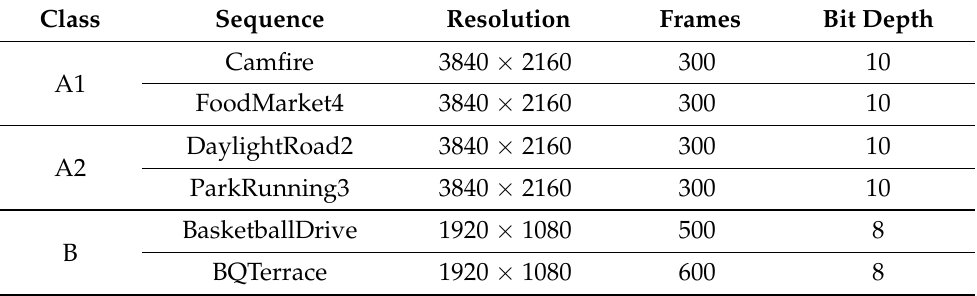
Table 1. Features of the VVC Bitstreams used in the